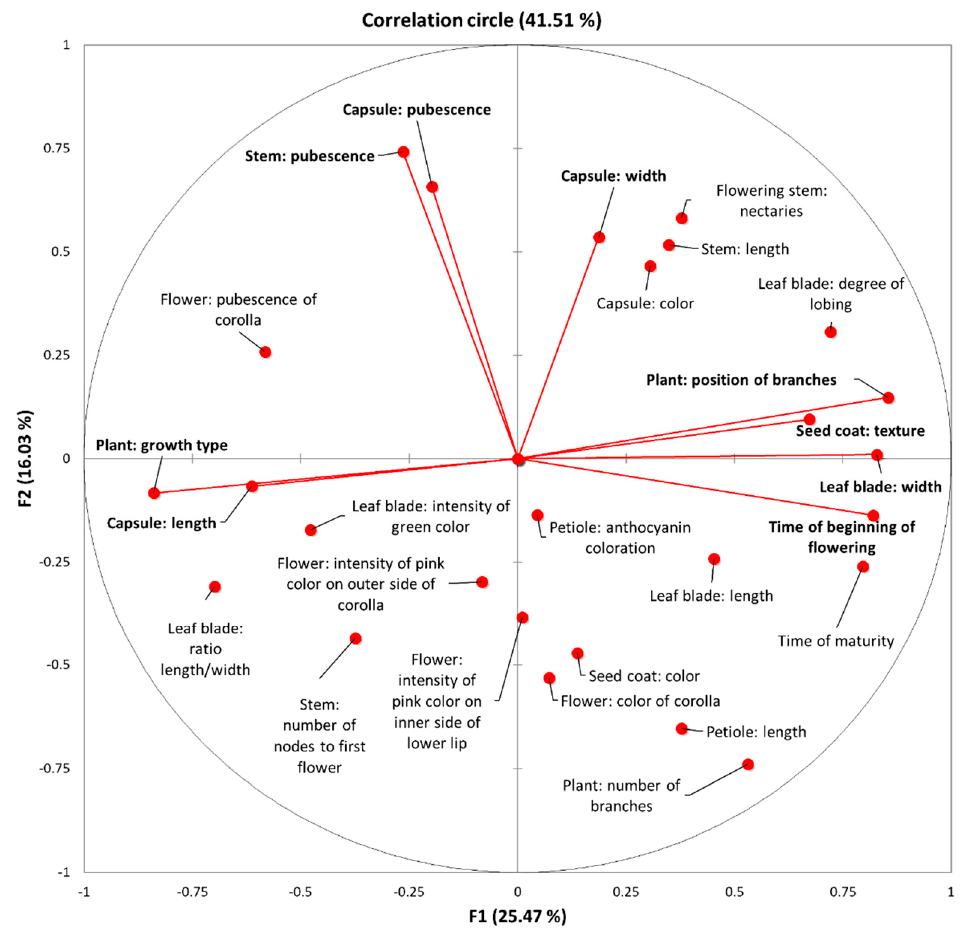
Figure 2. Correlation circle depicting the initial variables for the 37 sesame cultivars. Dots represent the projection of the different variables in the F1 and F2 components’ space. Variables with high squared cosine values, linked to the corresponding axes, are represented with red lines.